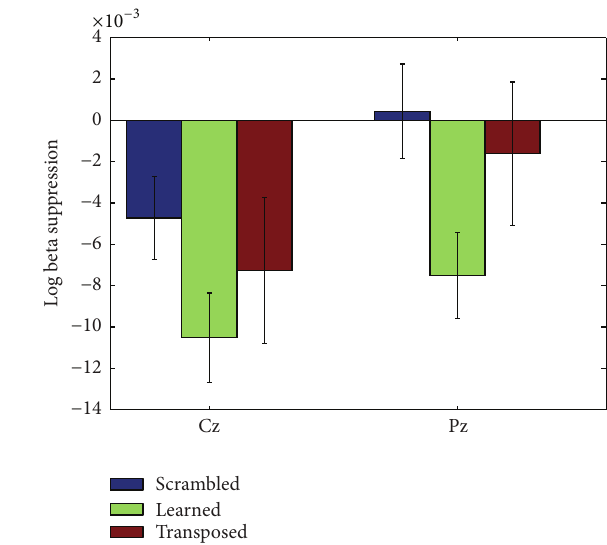
Figure 5: Beta suppression at electrodes Cz and Pz. Error bars represent standard error of the